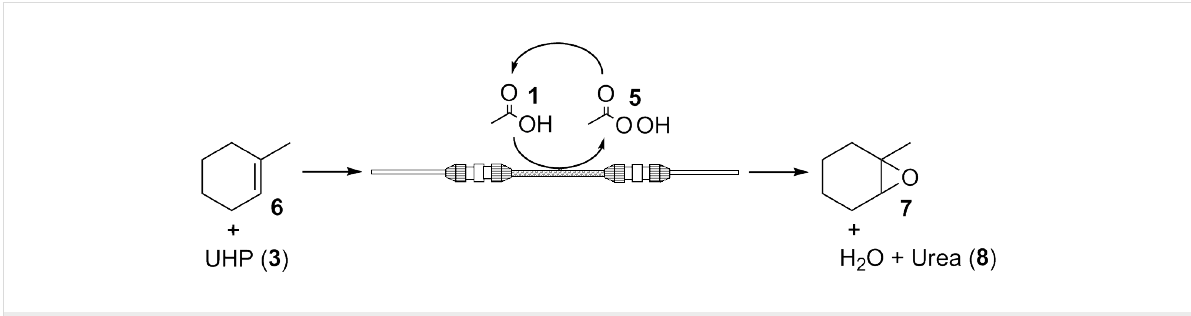
Figure 1: Schematic of the reaction set-up used to evaluate the continuous flow chemo-enzymatic epoxidation of 1-methylcyclohexene ( 6 ) via the perhydrolysis of acetic acid ( 1 ).